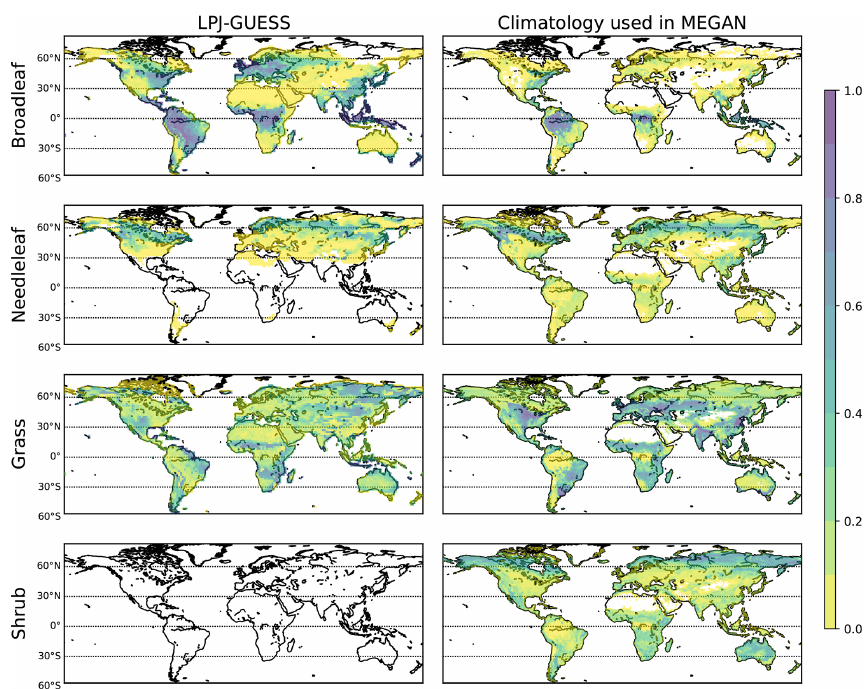
Figure 7. Fractional coverage for different vegetation classes used as inputs in MEGAN. The fractional coverage from LPJ-GUESS is displayed in the left panels, while the climatological fractional coverage is displayed in the right panels. Shrub PFTs are currently missing in the applied LPJ-GUESS global PFT